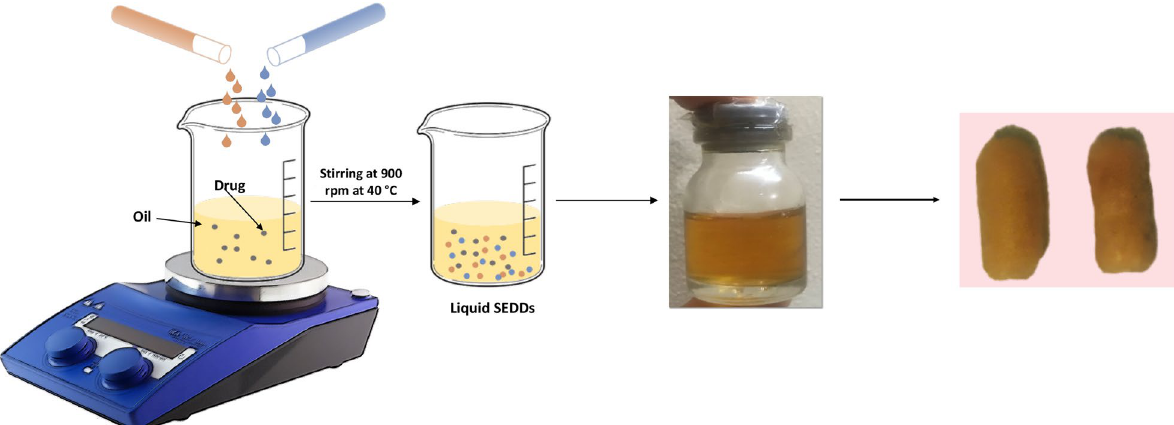
Fig. 1 Preparation of the KTZ-SEDDs and transformation of SEDDs into lipstick